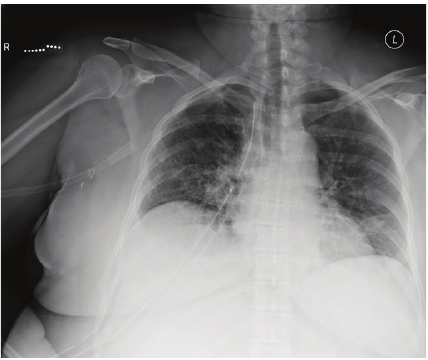
Figure 1: Postoperative chest X-ray. Seen are a single lumen ETT (DLT was replaced with SLT for bronchoscopy), three right chest tubes, and tiny right apical and basilar pneumothoraces. Infiltrate is observed throughout both lungs.